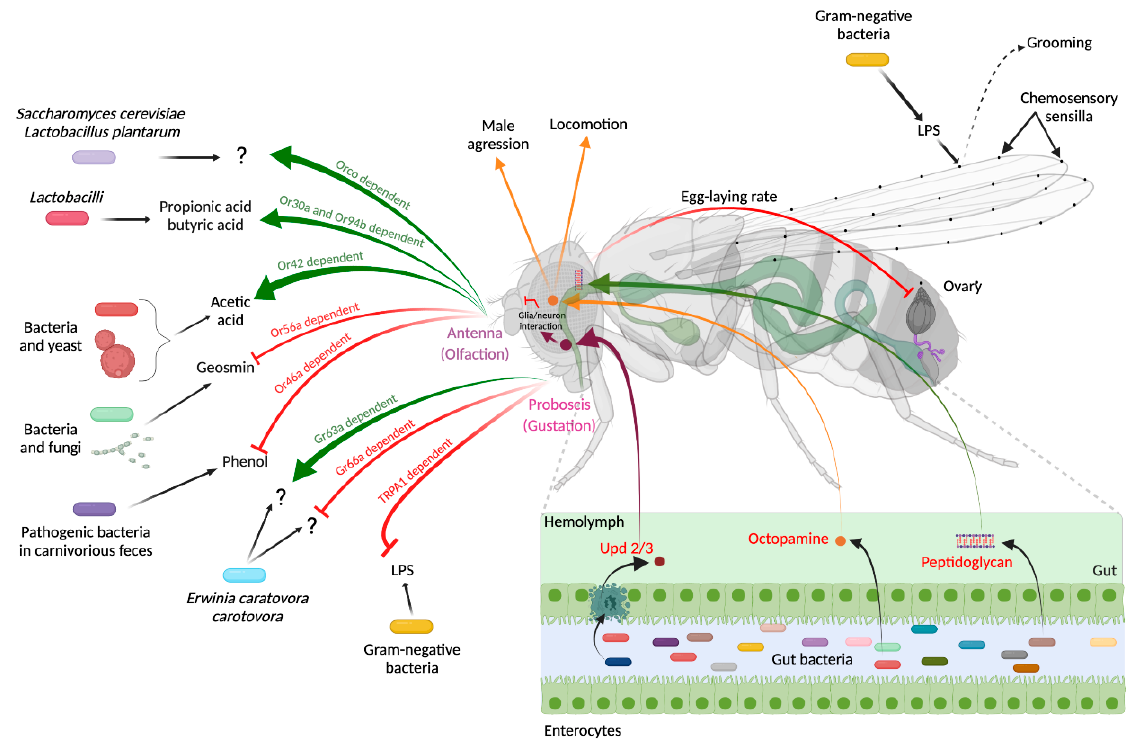
Figure 2. Mechanisms of interactions between microbes and the Drosophila nervous system. (See text for details).